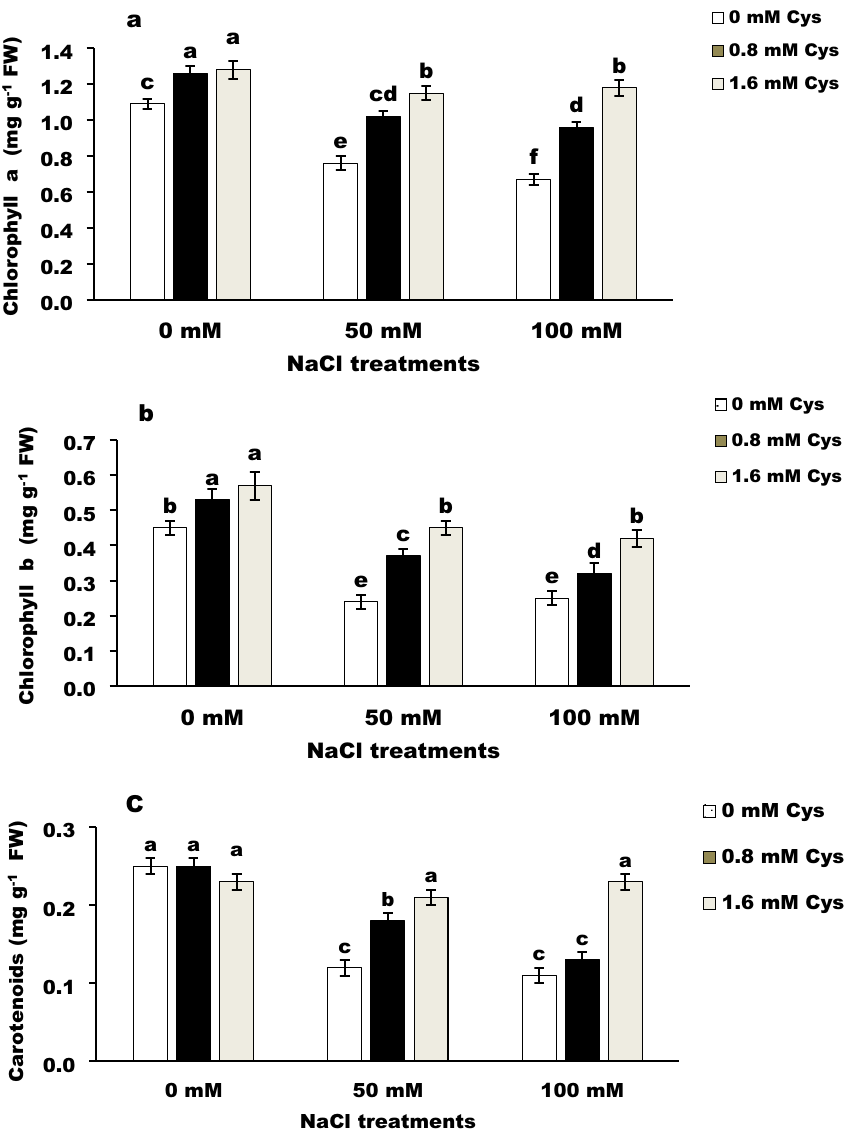
Figure 1. Effect of L-cysteine on photosynthetic pigments; chlorophyll a ( a ), chlorophyll b ( b ), and carotenoids ( b ) in salt-stressed flax plants. Differences are statistically significant at p < 0,05; vertical bars indicate ±